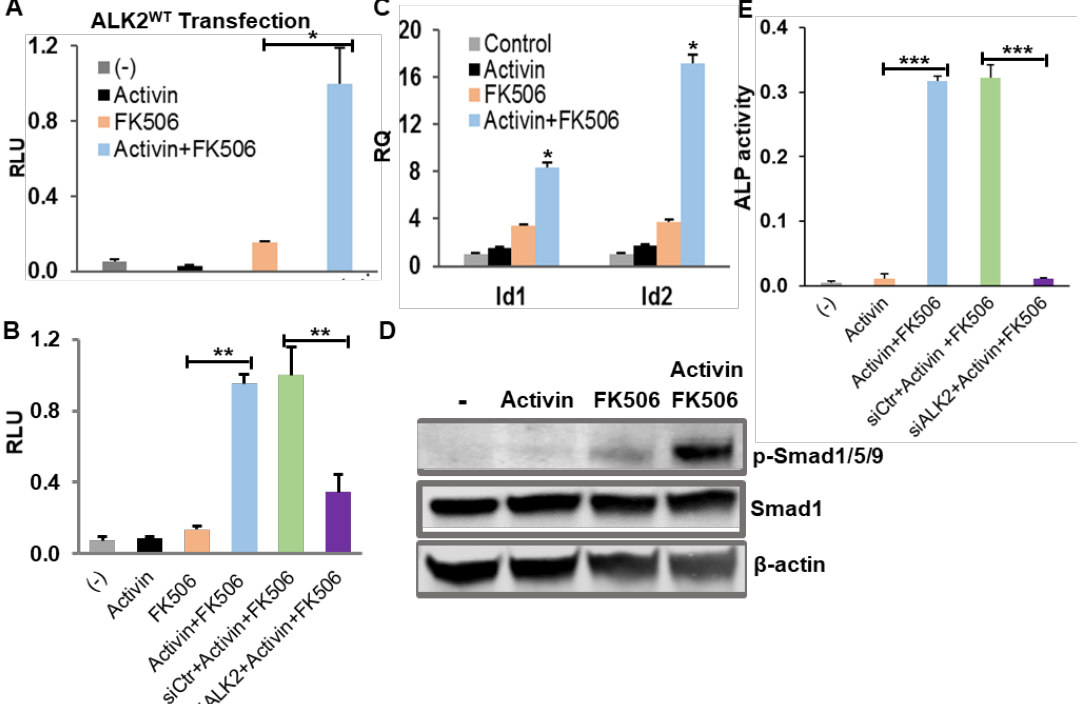
Figure 2. FKBP12 dissociation by FK506 enables ALK2 WT to mediate the activin A-induced BMP signaling. 1 µ M FK506 treatment significantly induced BMP signaling in the presence of 100 ng / mL activin A in the stably transfected BMP-responsive C2C12BRA cells ( A ) with ALK2 WT transfection and ( B ) without ALK2 WT transfection. Knockdown ALK2 by siRNA ALK2 (siALK2) resulted in a significant decrease in the activin A-induced BMP signaling in C2C12BRA cells (siCtr: scrambled siRNA). ( C ) RT-PCR showed that the mRNA expression levels of the BMP signaling target genes, Id1 and Id2, were dramatically elevated by the treatments of FK506 and Activin A. ( D ) Western blotting result indicated that the treatments of FK506 and activin A increased the expression of the phosphorylated Smad1 / 5 / 9 ( p -Smad1 / 5 / 9). ( E ) Alkaline phosphatase (ALP) assay results demonstrated that the treatments of FK506 and activin A significantly increased ALP activity in C2C12 cells and this ALP-induced activity is dramatically suppressed upon siRNA ALK2 knockdown. Results of luciferase assay and RT-PCR assay were represented as mean relative luciferase units (RLU) ± SEM and relative quantity (RQ) ± SEM ( n = 3, * p < 0.05, ** p < 0.01, *** p <